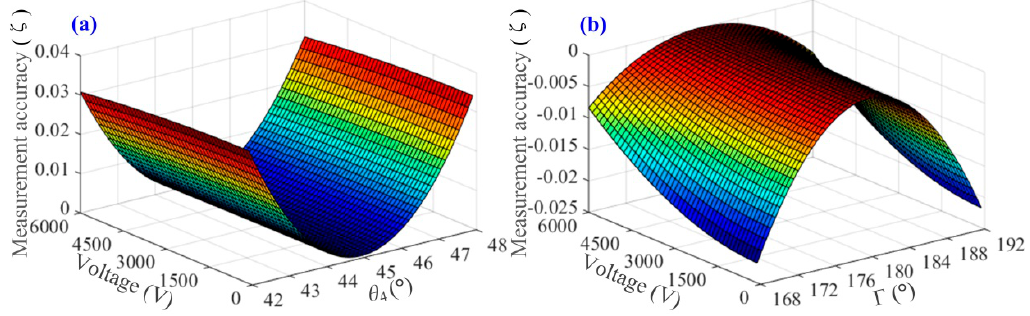
Figure 6. The relative measurement error of OVS when ( a ) the axis-angle between half-wave plate and BGO crystal θ 4 is varying or ( b ) the phase delay angle of half-wave plate г is varying.